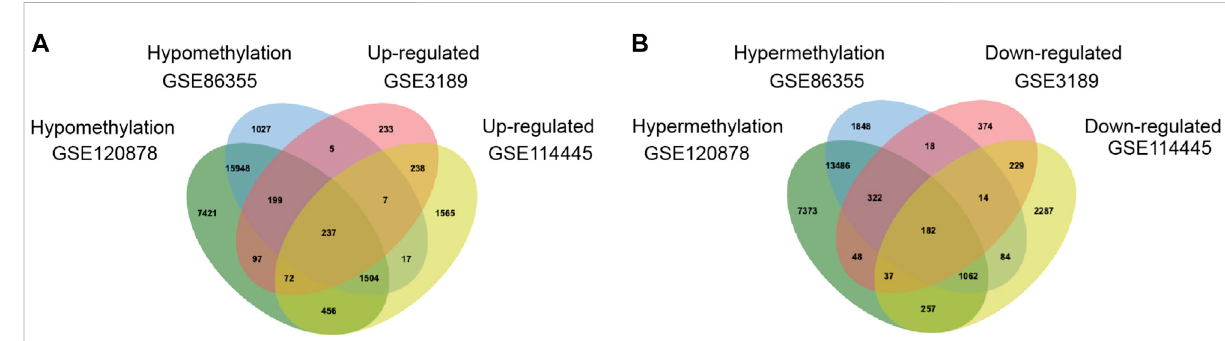
FIGURE 1 Identi fi cation of methylation-regulated differentially expressed genes(MeDEGs) in gene expression datasets (GSE3189 and GSE114445) and gene methylation datasets (GSE86355 and GSE120878). (A) hypomethylation and upregulated genes; (B) hypermethylation and down-regulated genes.